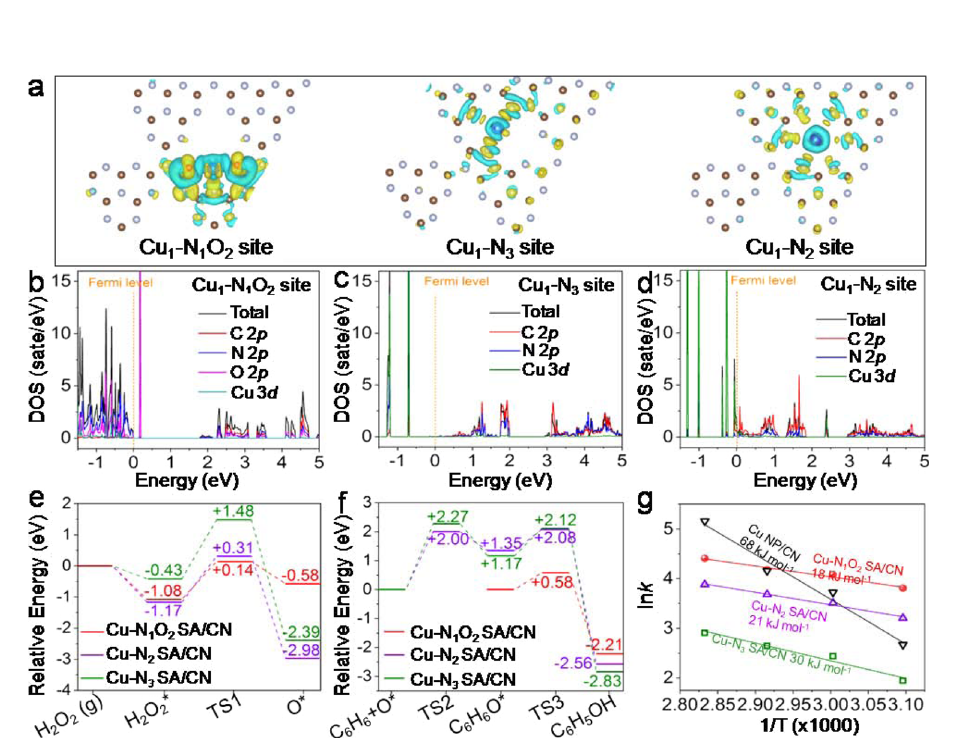
Fig. 5 | DFT simulations of catalytic activity and electronic structure. a Differential charge density of Cu 1 -N 2 , Cu 1 -N 3 and Cu 1 -N 1 O 2 coordination con fi g- uration. b – d The density of states of Cu 1 -N 1 O 2 coordination con fi gurations.